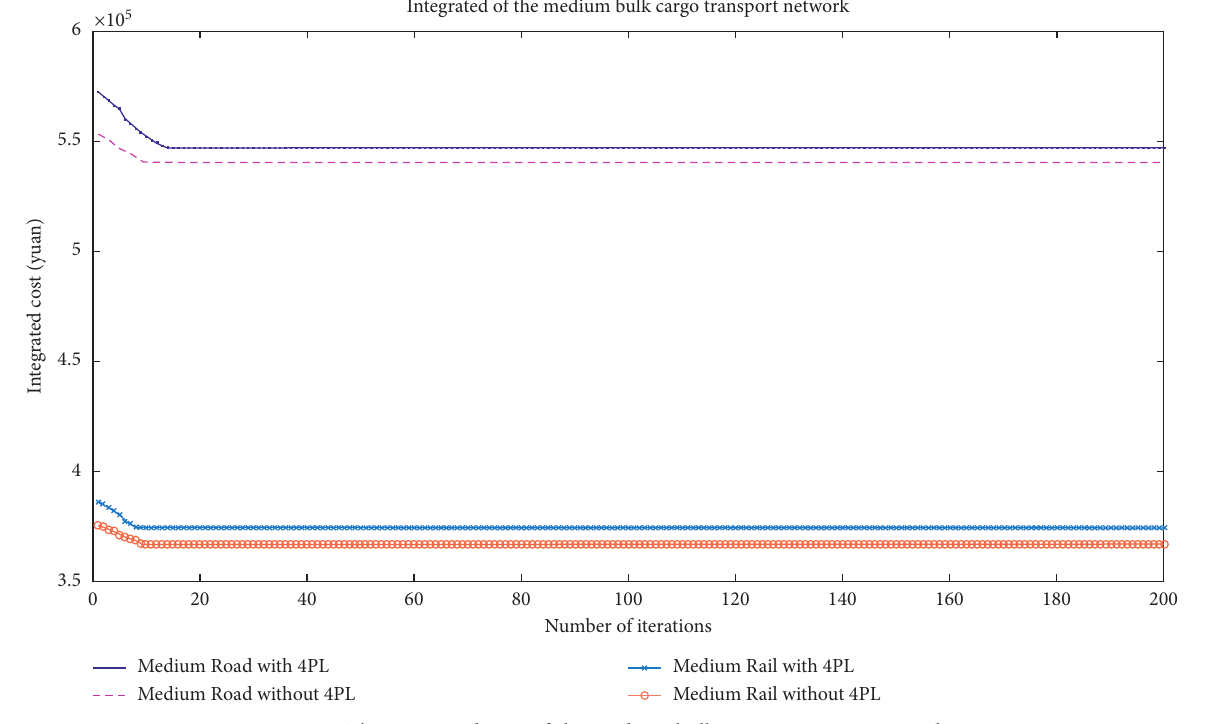
Figure 4: The integrated cost of the medium bulk cargo transport network. Table 8: The flow of supply and demand points in the medium bulk cargo transport